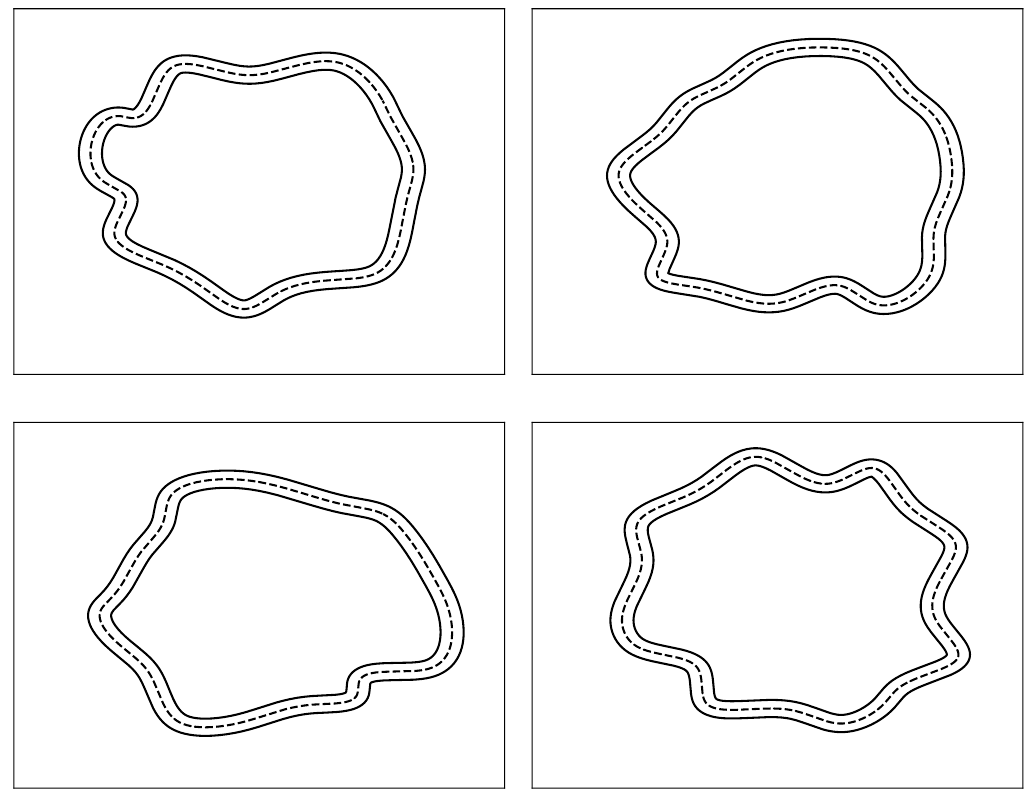
Figure 1. Examples of randomly generated trajectories for